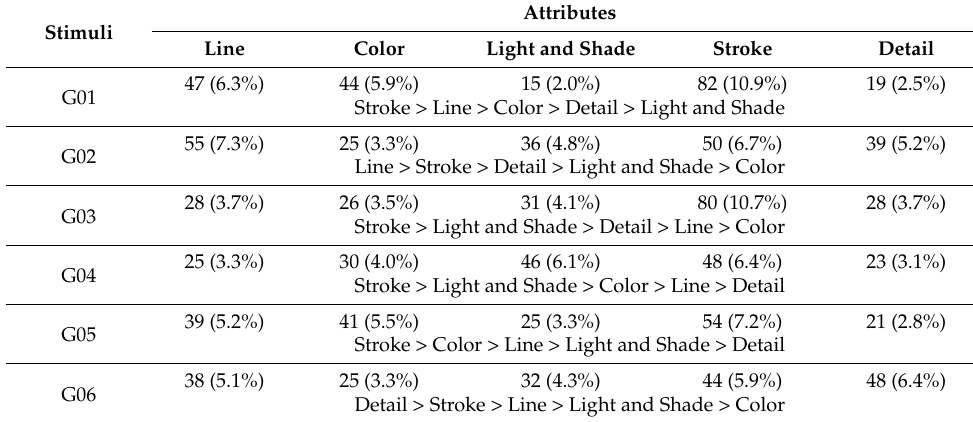
Table 9. The number of votes for the other five